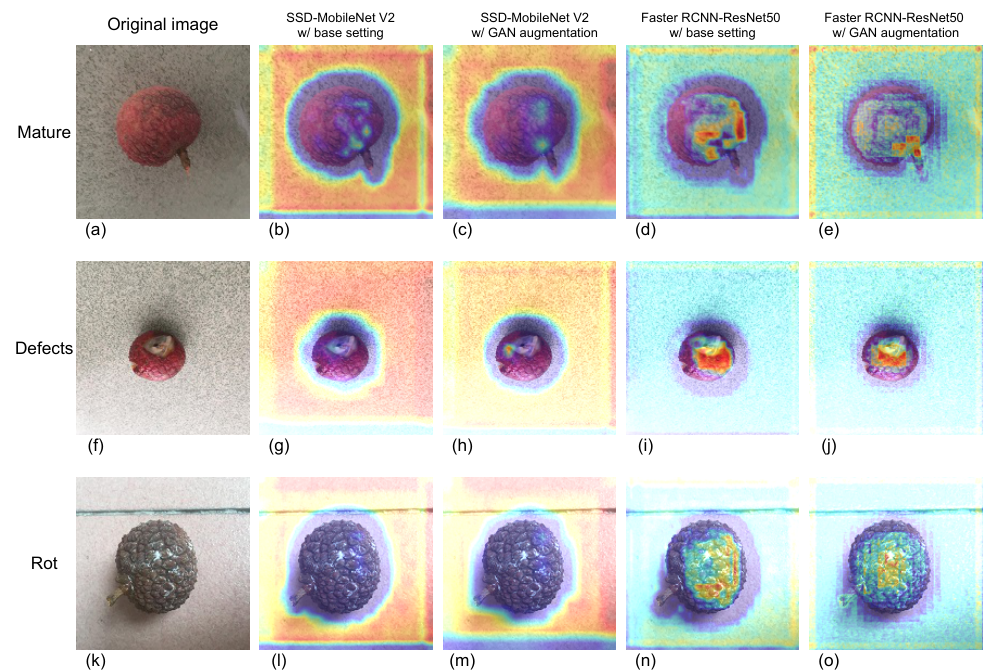
Figure 12. Activation heatmap. ( a , f , k ) are the original samples; ( b , g , l ) are the heatmaps for SSD- MobileNet V2 w/ base setting; ( c , h , m ) are the heatmaps for SSD-MobileNet V2 w/ GAN augmenta- tion; ( d , i , n ) are the heatmaps for Faster RCNN-ResNet50 w/ base setting; ( e , j , o ) are the heatmaps for Faster RCNN-ResNet50 w/ GAN